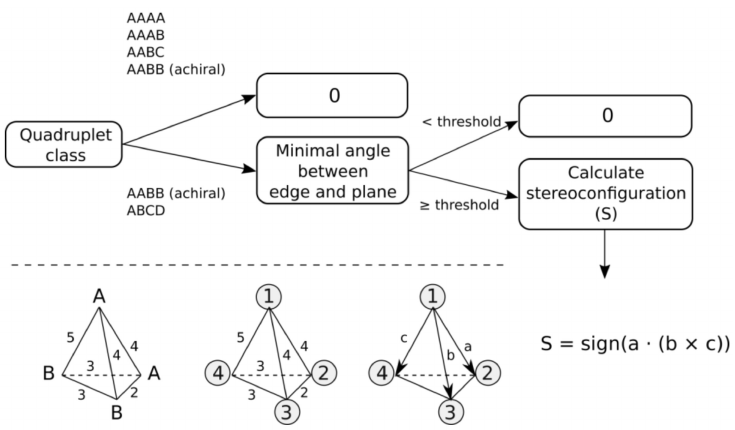
Figure 3. The workflow to determine configuration sign of quadruplets. Labels A and B designate canonical feature identifiers. Numbers on edges designate binned distances. Numbers in circles are ranks of vertices. Labels a, b and c designate vectors.